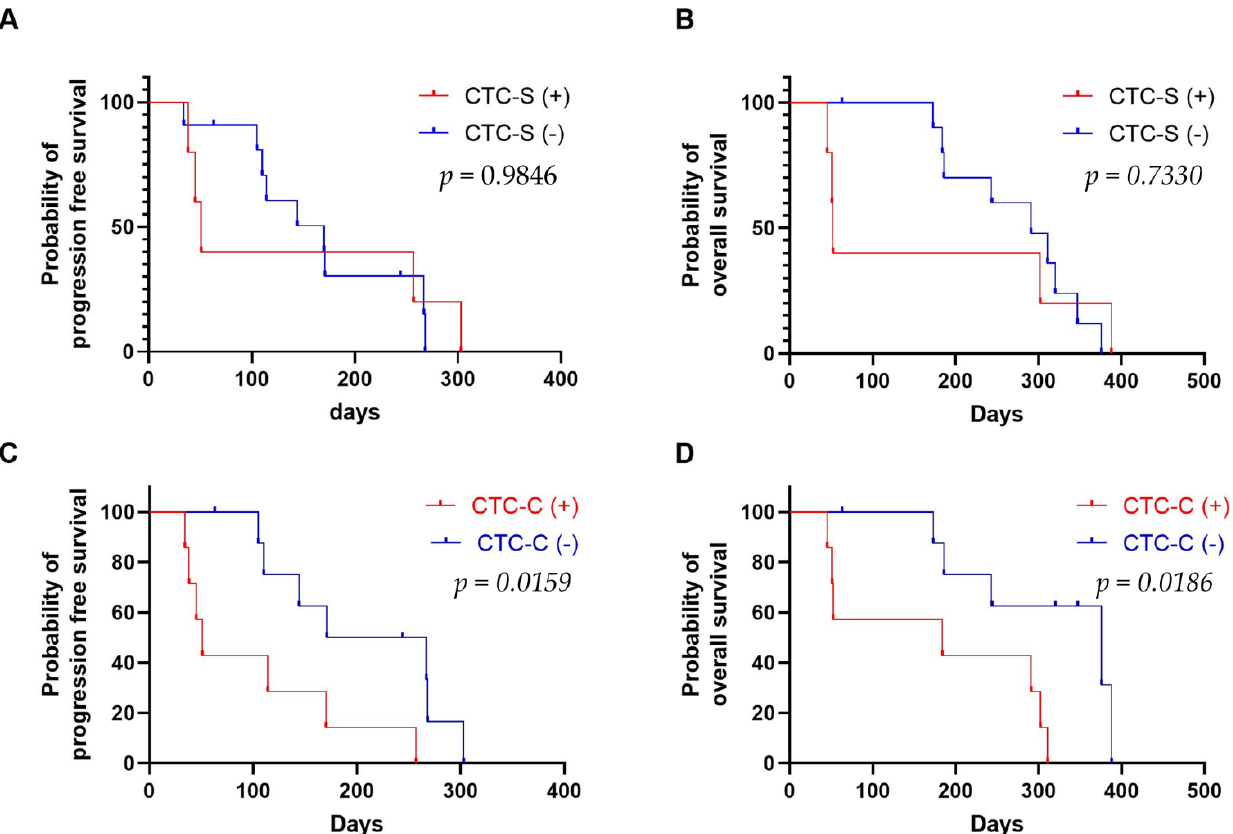
Figure 5. Survival analysis. ( A ) Progression-free survival and ( B ) overall survival according to the presence of CTC-S (single CTCs) among the 16 pancreatic cancer patients. ( C ) Progression-free survival and ( D ) overall survival according to the presence of CTC-C (CTC clusters) among the 16 pancreatic cancer patients. CTC-S (+) and CTC-C (+) are for the patients who have one or more single CTCs and CTC clusters, respectively. CTC-S (-) and CTC-C (-) are for the patients who do not have single CTCs and CTC clusters, respectively.